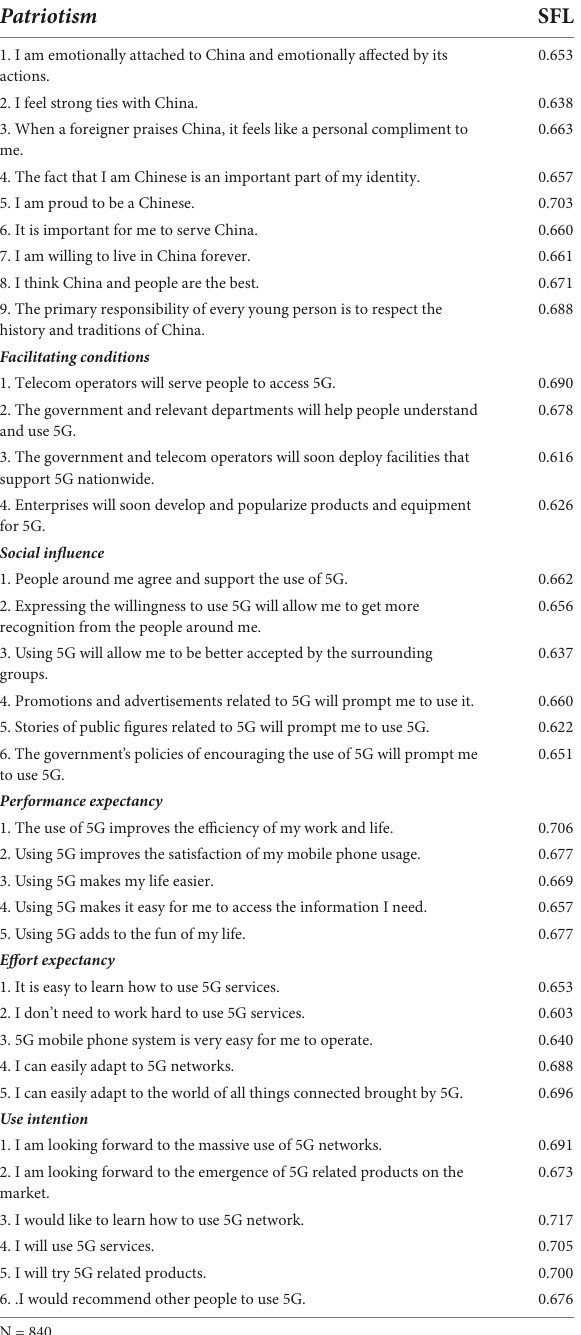
TABLE 1 Measurement items and standardized factor loading.